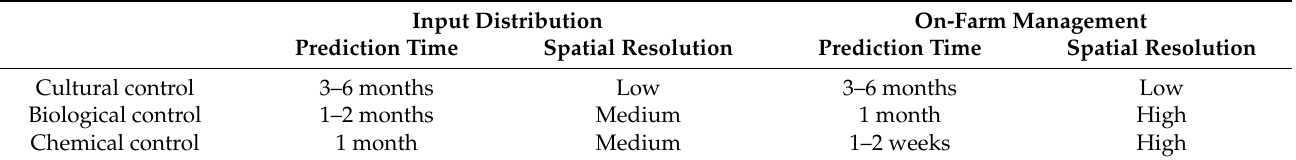
Table 3. Results on different management options derived from survey